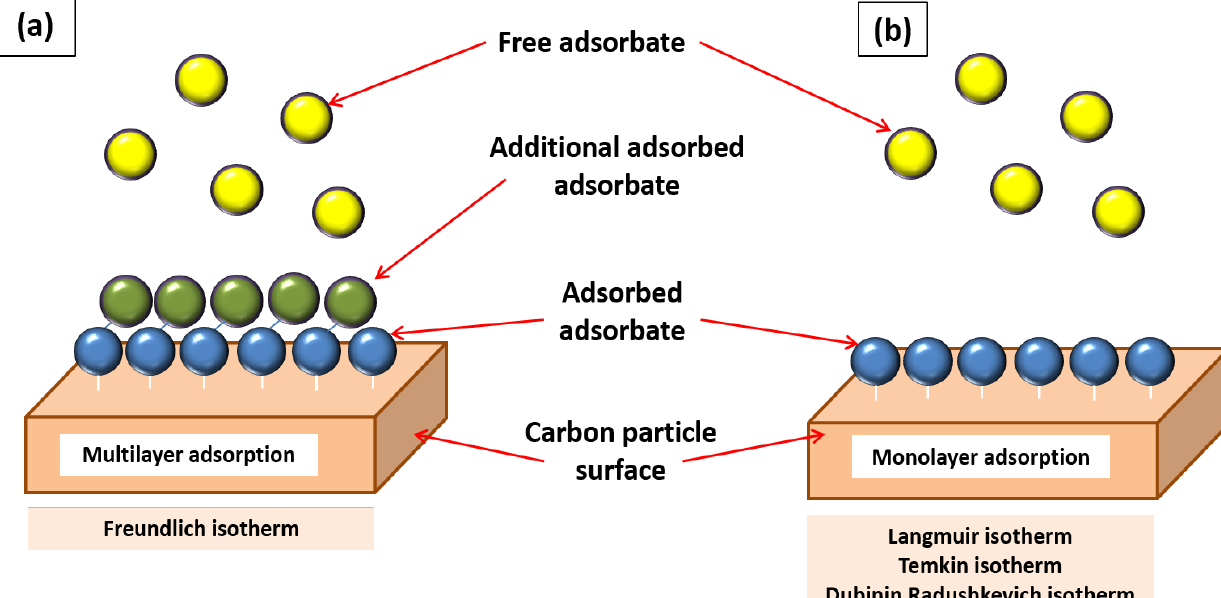
Fig. 1. Illustration of adsorption profile in multilayer (a) and monolayer (b)